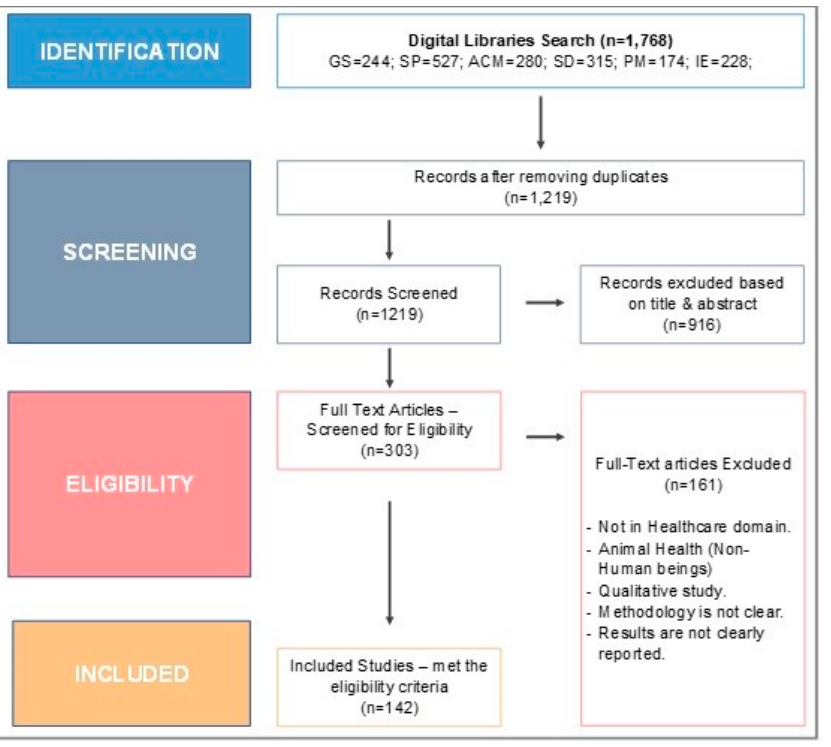
Figure 1. PRISMA flow diagram.